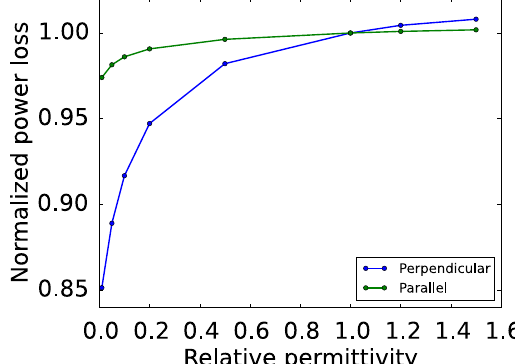
Figure 1. Preliminary analysis of the dielectric coat. Trend of the power loss on the titanium cylinder for different relative permittivity values of the dielectric coat. The power dissipated is normalized to the power loss without any coat. The “perpendicular” line refers to the case of a cylinder with its axis perpendicular to the direction of propagation of the electromagnetic wave; the “parallel” one to the case of a cylinder with its axis parallel to the direction of propagation of the electromagnetic